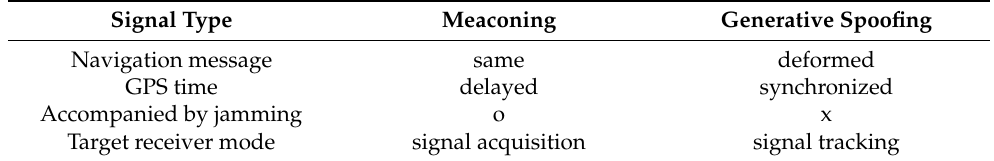
Table 1. Classification of GPS spoofing